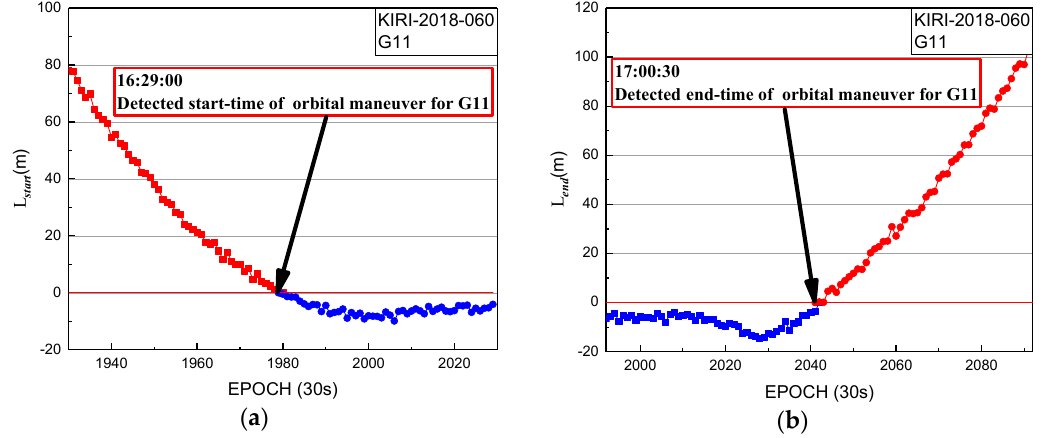
Figure 13. Detection results of KIRI station for G11 on 1 March 2018. ( a ) Start time factor of KIRI station for G11 on 1 March 2018; ( b ) end time factor of KIRI station for G11 on 1 March 2018. Note: the data of station KIRI with a 30 s sampling period from Multi-GNSS Experiment (MGEX) are selected to be analyzed.